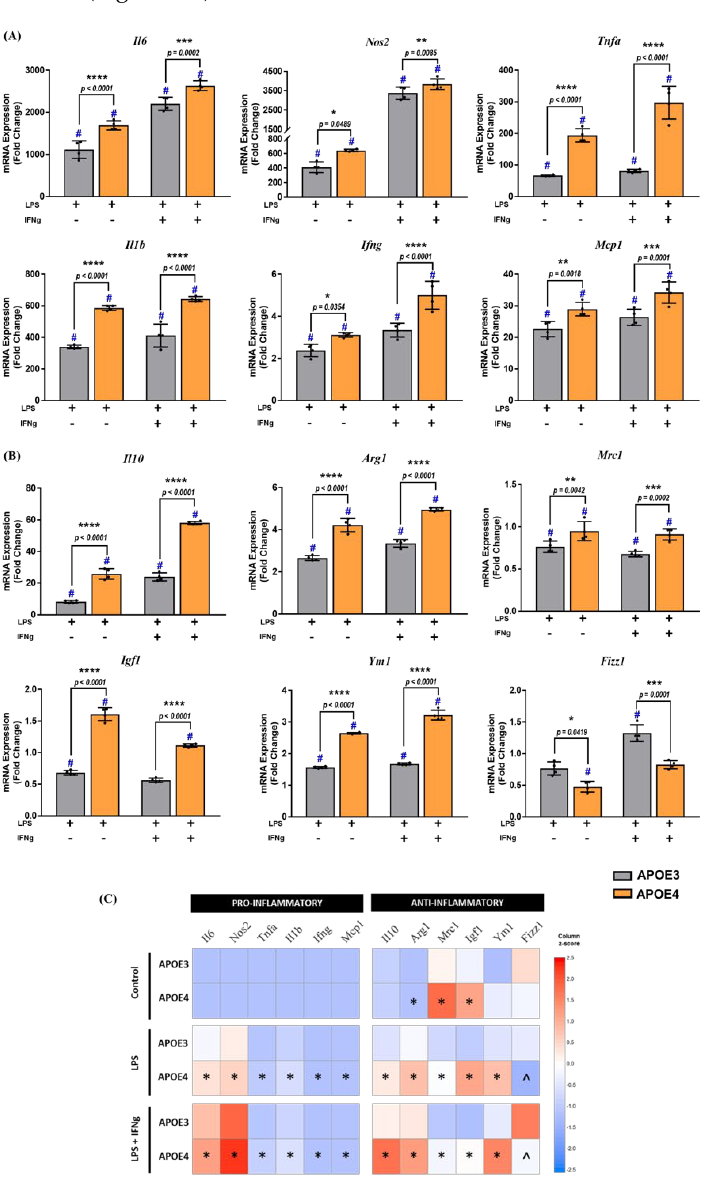
Figure 3. Comparison of gene expression between APOE3 and APOE4 genotypes: ( A ) pro − and ( B ) anti − inflammatory gene expression was evaluated in mixed − sex microglia from APOE3 and